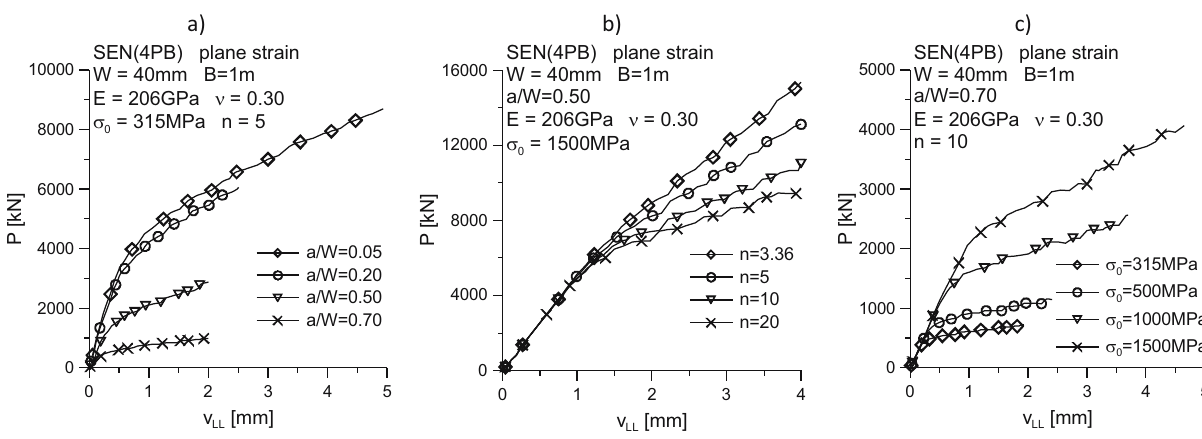
Figure 13: In fl uence of the relative crack length a / W ( a ) , the strain hardening exponent n ( b ) , and the yield point σ 0 ( c ) on the P = f ( v LL ) curves, used to determine energy A in formula ( 2 ) .